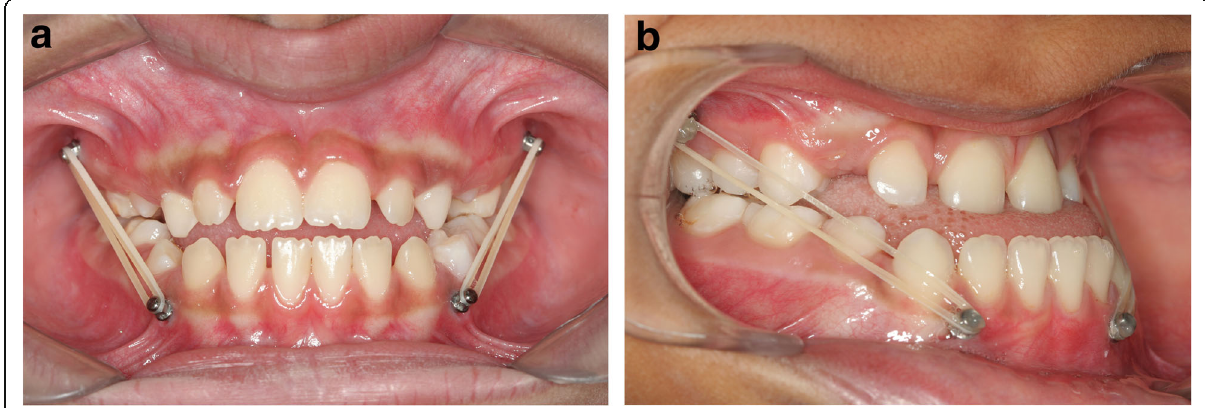
Fig. 1 Patients of group MI with mini-implants and intermaxillary elastics inserted. Verify the difference in the position of the mini-implants in a and b resulting from the need for inter-radicular